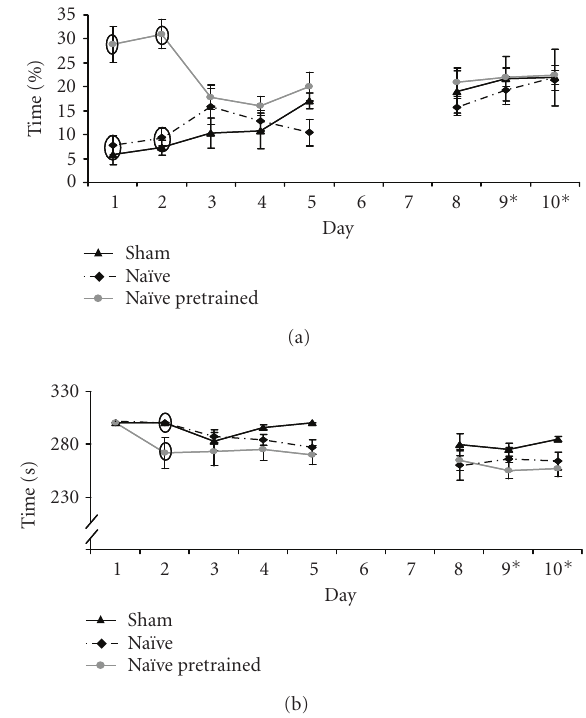
Figure 3: Examples of behavior of the mice during the followup ex- periment. (A) Percentage of time spent on center board. (B) Time to finish the task (5 minutes or finding all three baits) of sham (black line), na¨ıve (striped black line), and na¨ıve mice preexposed to a bait- containing cylinder in the homecage (grey line). Days 9 and 10 on the x -axis indicate removal of rings from all cylinders, while the bait remained in the same cylinders. Data present the mean of the three trials per day ± SEM. Ovals mark data points with significant dif- ferences: P < . 05 between groups within